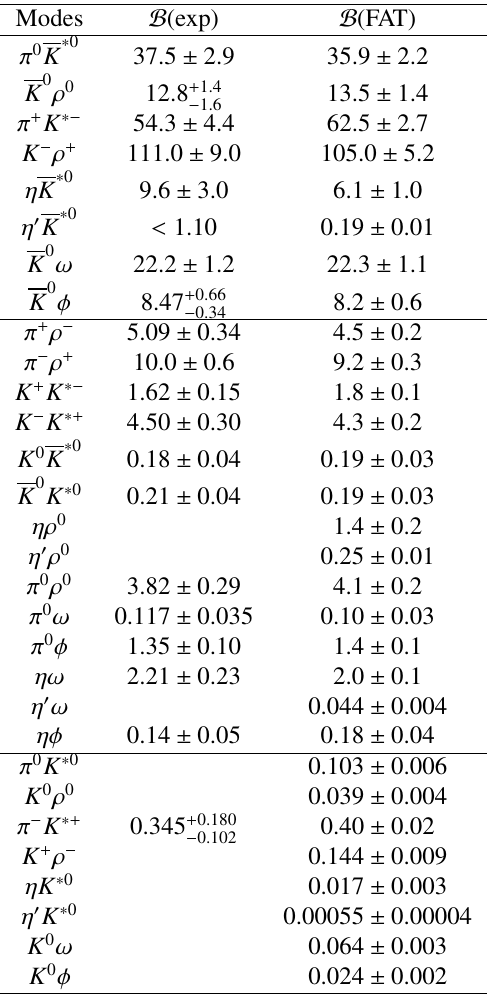
Table 2. Same as Table I but for the D 0 → PV